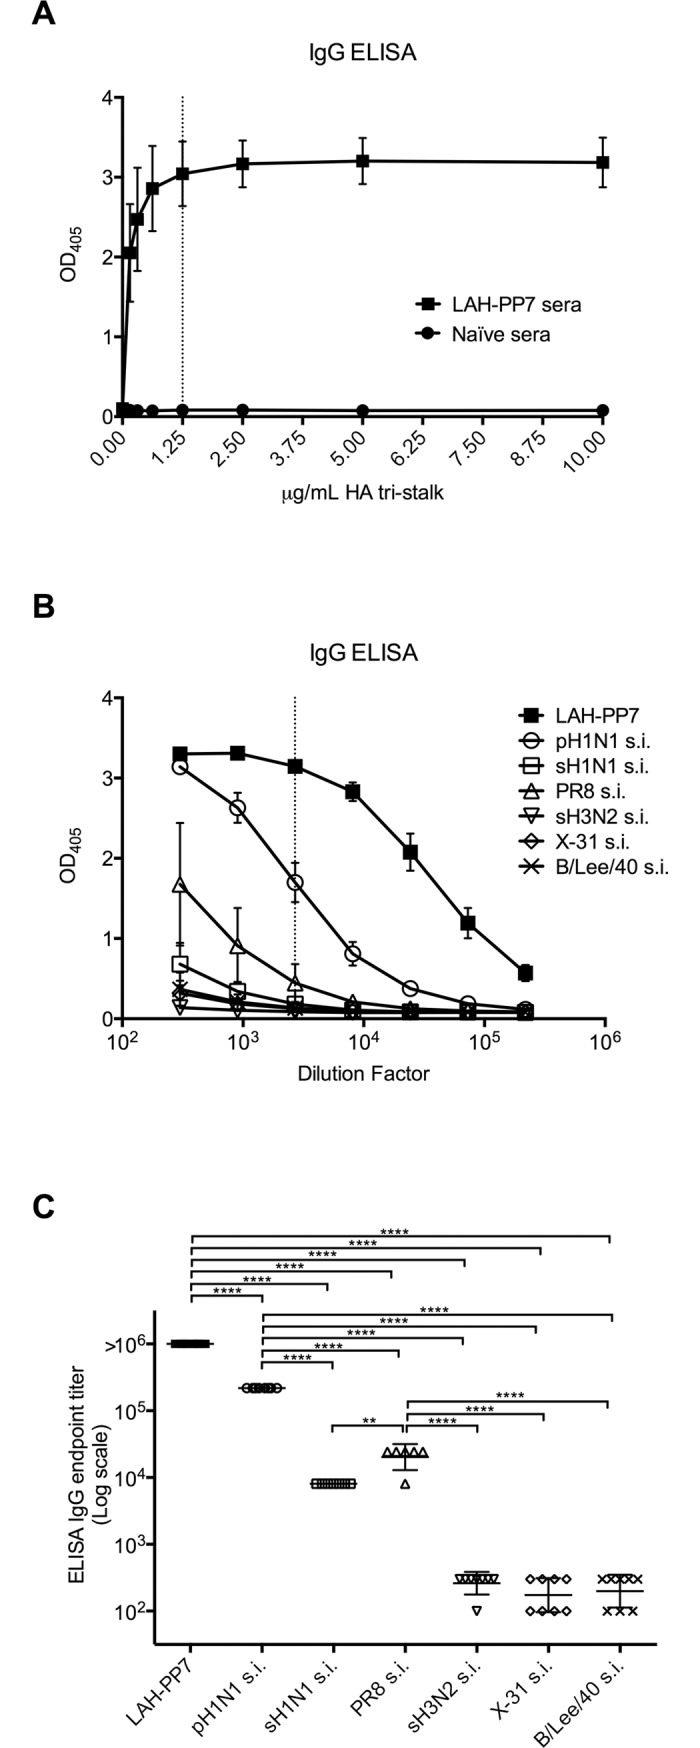
HA tri-stalk specific seroreactivity in mice.(A) Serial dilutions of HA tri-stalk protein (0.15625, 0.3125, 0.625, 1.25, 2.5, 5.0 and 10.0 μg/mL) tested against 1:2700 dilution of sera from LAH-PP7 vaccinated mice or naïve mice. (B) Total IgG ELISA was used to determine the HA tri-stalk specific seroreactivity induced by vaccination with LAH-PP7 or by sublethal infection (s.i.) of A/Luxembourg/46/2009 pandemic H1N1 (pH1N1), A/Texas/36/91 seasonal H1N1 (sH1N1), A/Puerto Rico/8/34 H1N1 (PR8), A/Lux/01/2005 seasonal H3N2 (sH3N2), A/Aïshi/68 H3N2 (X-31), or B/Lee/40 virus. Total HA tri-stalk specific IgG titers were assayed in sera after the third immunization with LAH-PP7 or after 2 weeks post sublethal virus infection. (C) Comparison of HA tri-stalk specific IgG endpoint titers (n = 8 mice/group; **p<0.001, ****p<0.00001).